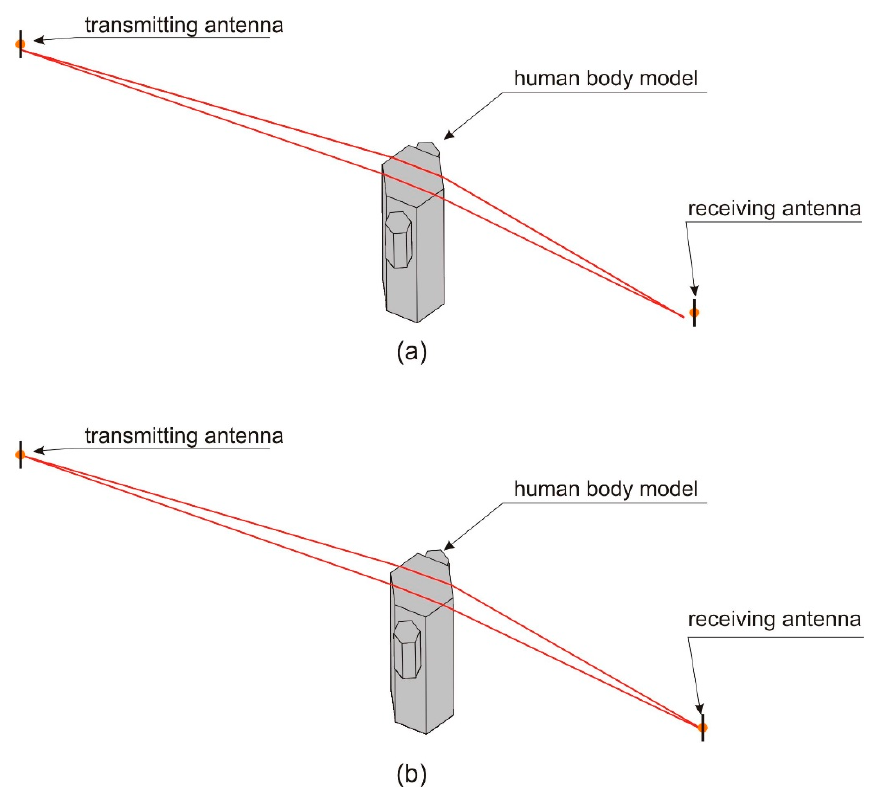
Figure 8. Ray-paths for human body models with six sidewalls: ( a ) For the receiver located at the distance, b = 1 m; ( b ) For the receiver located at the distance, b = 1.1 m.